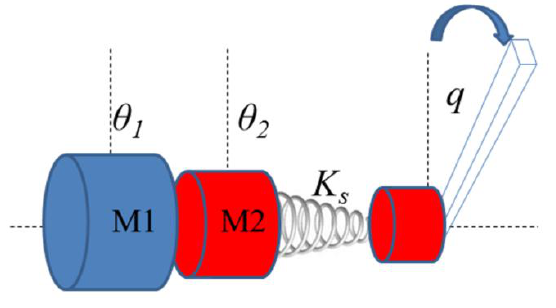
Figure 5. Series class of stiffness adjustment mechanism based on changing the spring’s deflection.